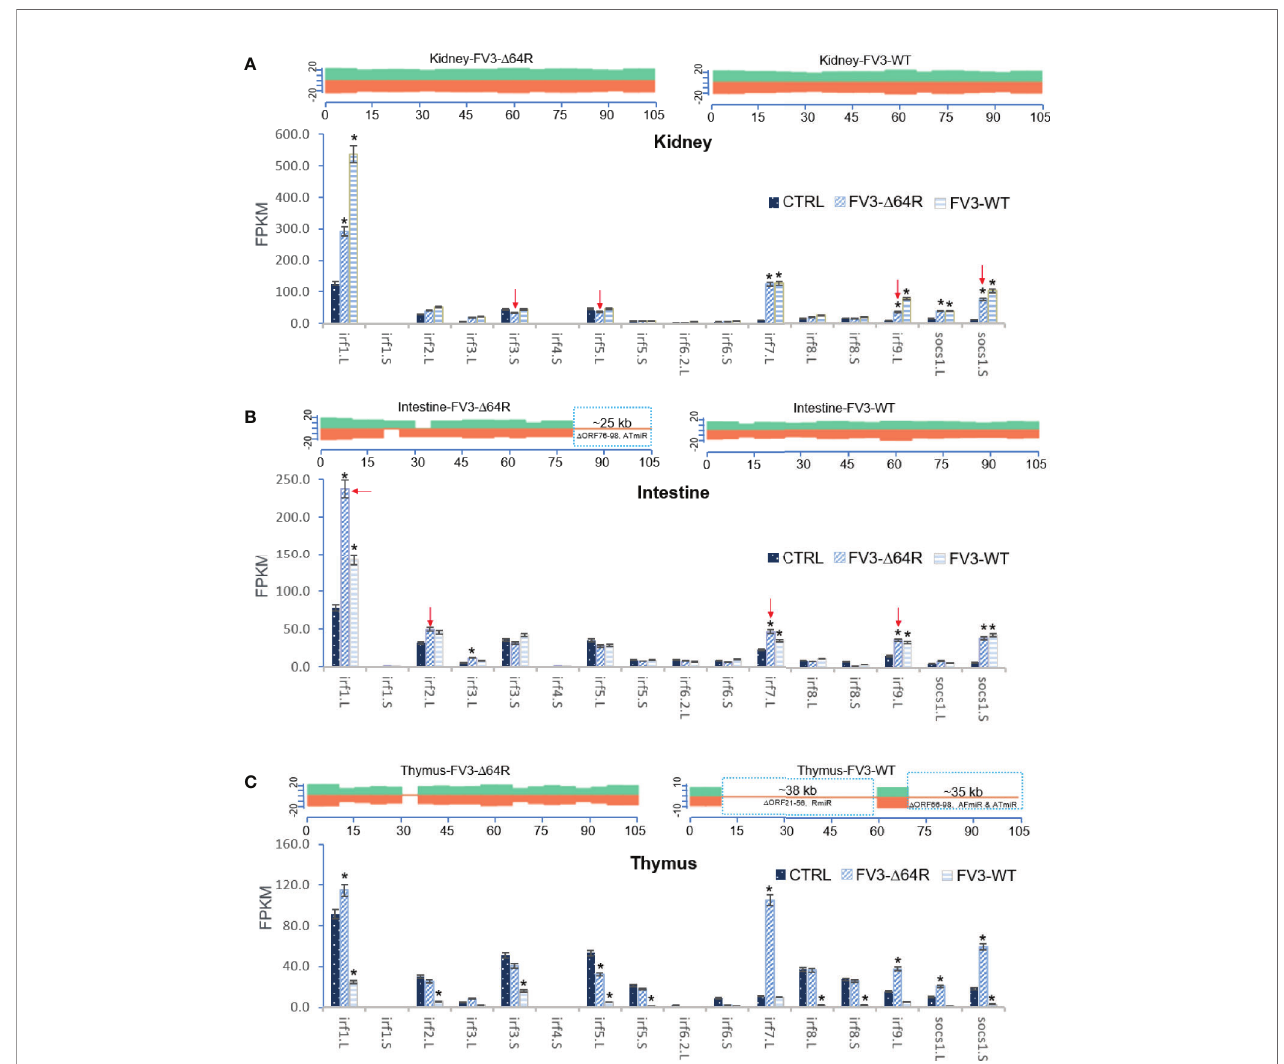
FIGURE 9 | Transcriptomic comparison of the viral genome and X. laevis mRNA encoding interferon IFN regulatory factors (irf) in the mock, FV3- D 64R and FV3-WT infected kidney (A) , intestine (B) , and thymus (C) . The distribution plots of mapped reads alone FV3 genome (GenBank Accession No. NC_005946.1) is shown as in Figure 3 with a full-genome coverage for the infected kidney samples. Partial coverages of the viral genome were determined in the FV3- D 64R infected intestine and for both FV3-WT and FV3- D 64R in the infected thymus. Comparative alignments indicates that transcripts of some ORFs and miRNA-enriched intergenic regions are defective (labeled and framed using blue line) as compared between two virus strains. Analysis shows reduced expression of IRF genes corresponding to potential higher expression of respective miRNA by FV3- D 64R in kidney and FV3-WT in intestine (indicated by red arrows). However, miRNA-mediated reduction of IRF genes is not detected in FV3- D 64R infected thymus. This suggests a tissue- and virus strain-dependent expression of miRNA and interference on host gene targets. Abbreviations and gene accession numbers are listed in Table 1 . *p (FDR) < 0.05 relative to the